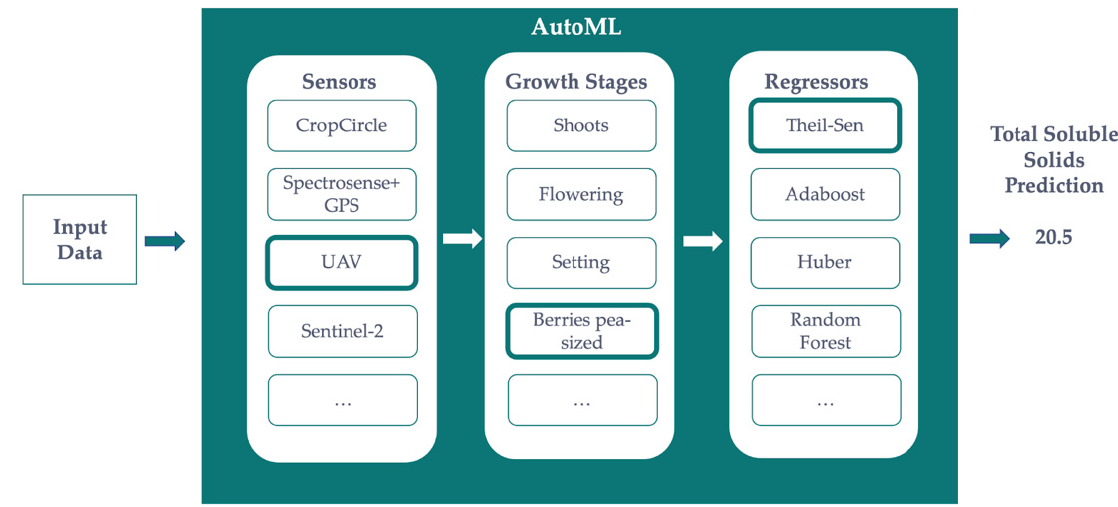
Figure 4. Architecture of the AutoML-based solution proposed in this research.